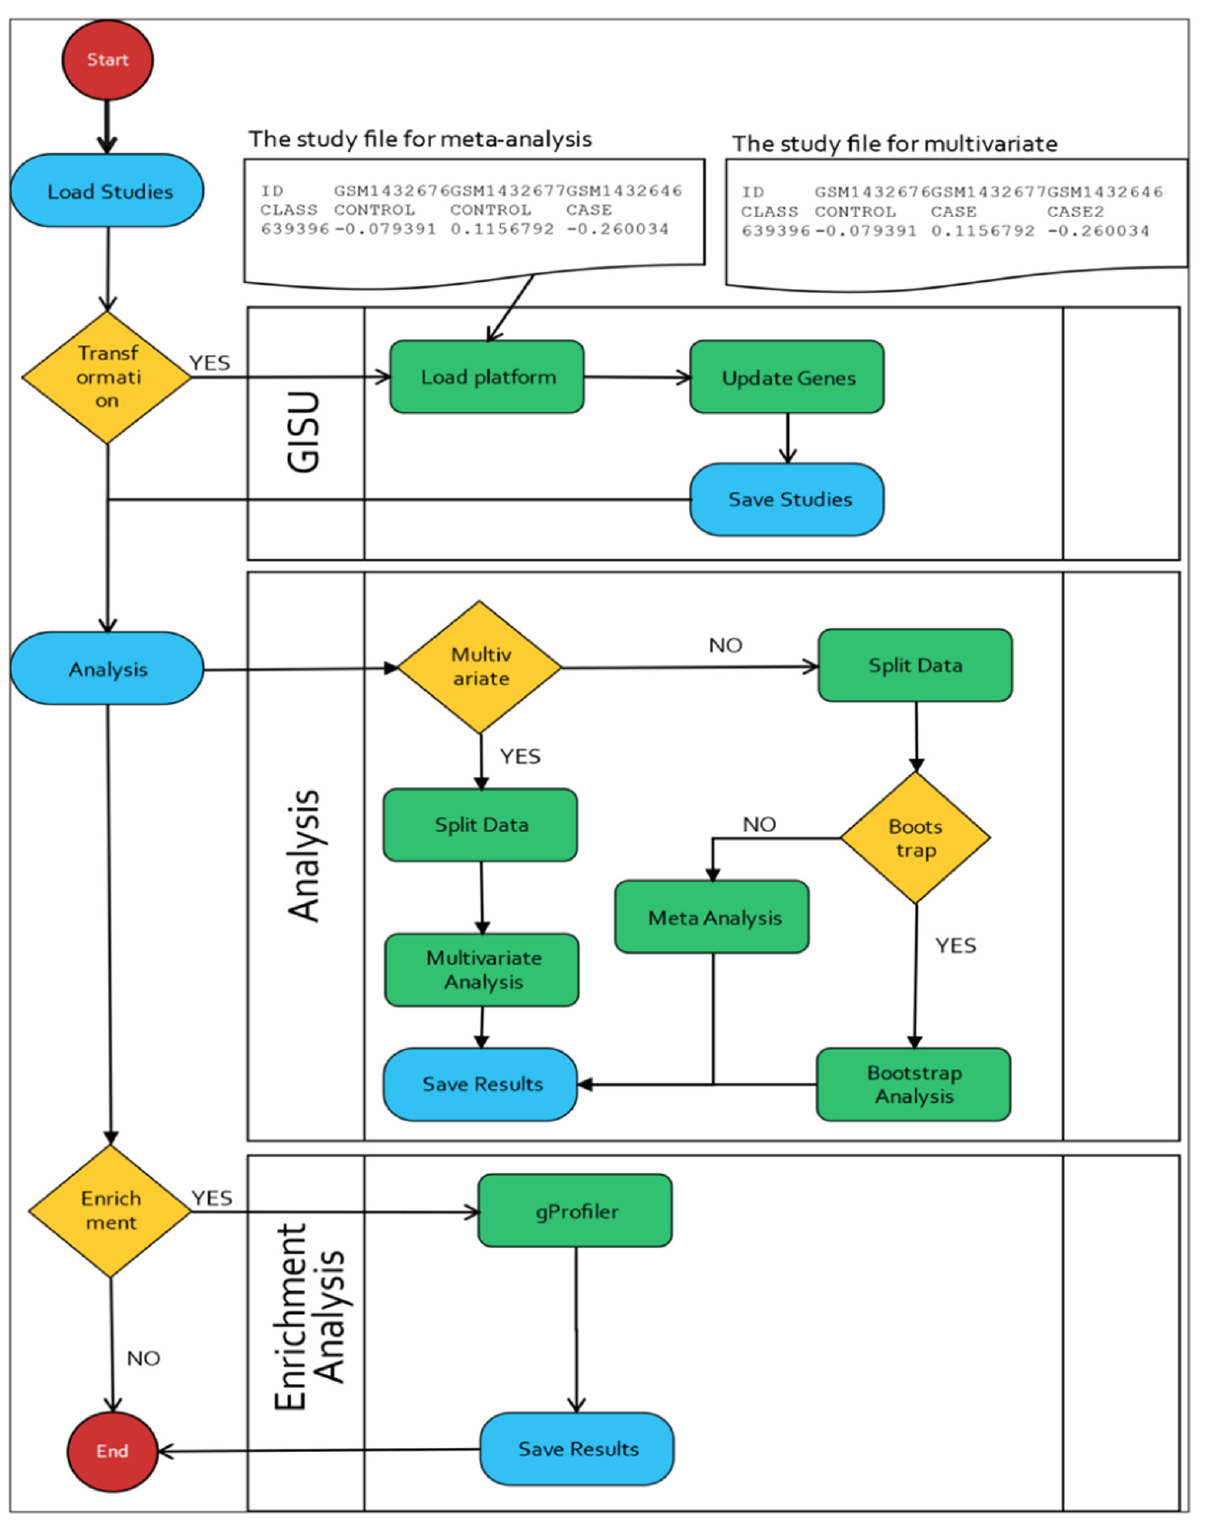
Figure 1. Schematic representation of the workflow.